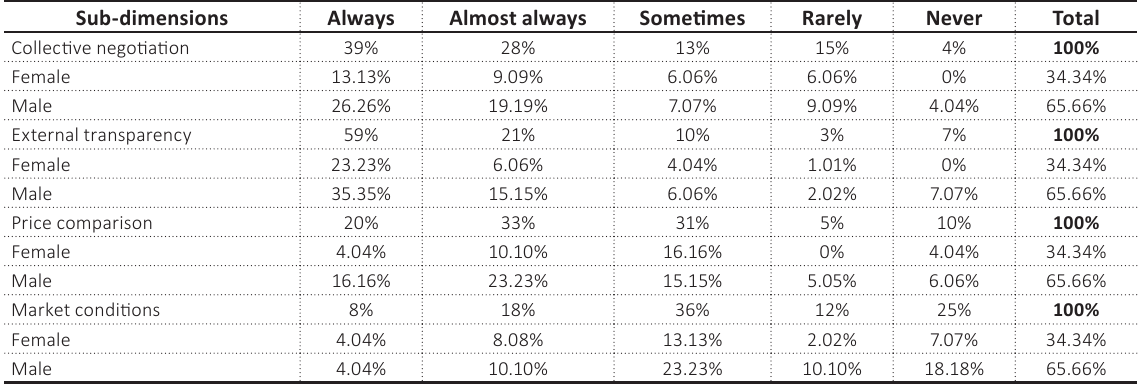
Table 4. Fairtrade practices and sub-dimensions